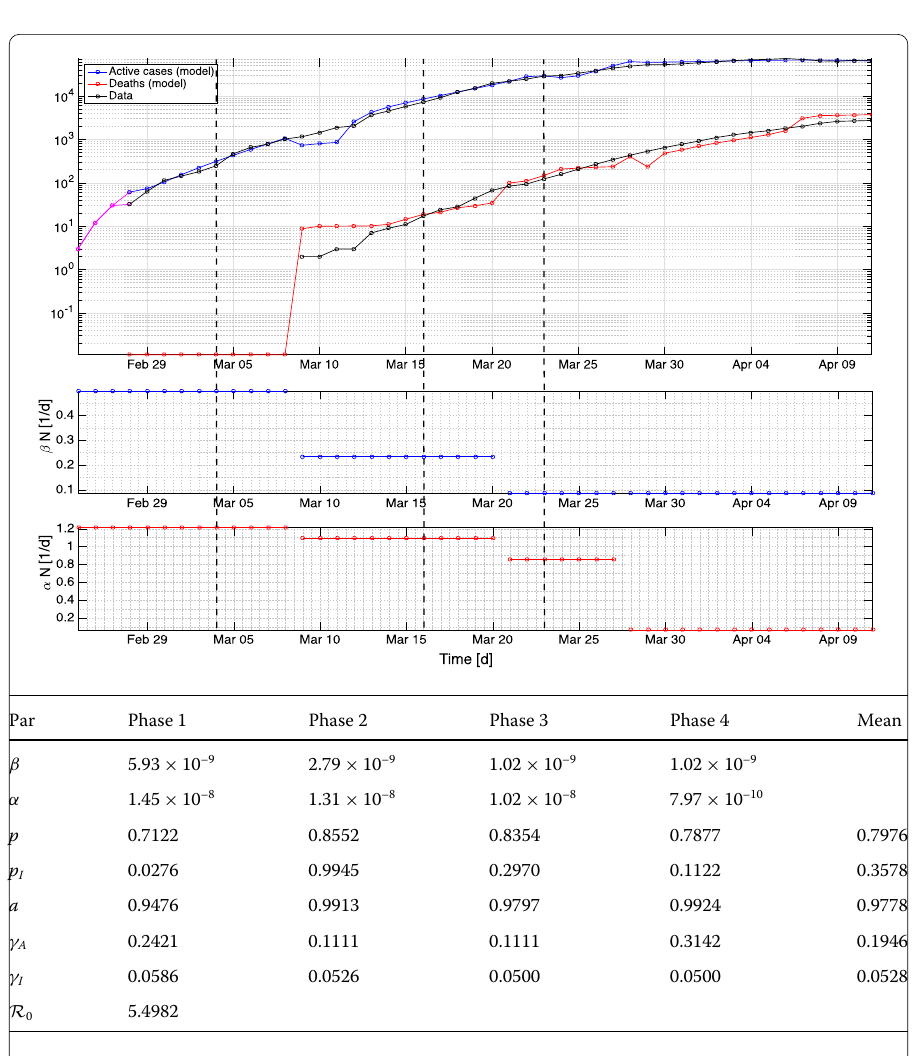
than the usual susceptible–asymptomatic transmission outside of hospitals in the later phases. The mean values (0.3578 for Germany, 0.5790 for Sri Lanka) lead to the hypothesis that Sri Lankan medical staffs pose higher risk of getting infected in hospitals. A possible reason may be related to the reported irresponsible behavior of several COVID-19 pa- tients who have been admitted to the hospitals without providing real information about their symptoms, historical whereabouts, and close connections to COVID-19 exposed in- dividuals and even hiding from the health officials in backtracking [41–43]. Moreover, the proportion of asymptomatic cases a is generally high for both countries (0.9778 for Germany, 0.9091 for Sri Lanka). This number weighs the exposed humans to be assigned to either the asymptomatic A or symptomatic I compartment in the optimal way such that the active cases pA + I match with data. This process is done without scrutinizing what happen to the A and I compartment individually. This modeling study owes a pos- sible correction to the value of a due to the unavailability of the hospitalized data for